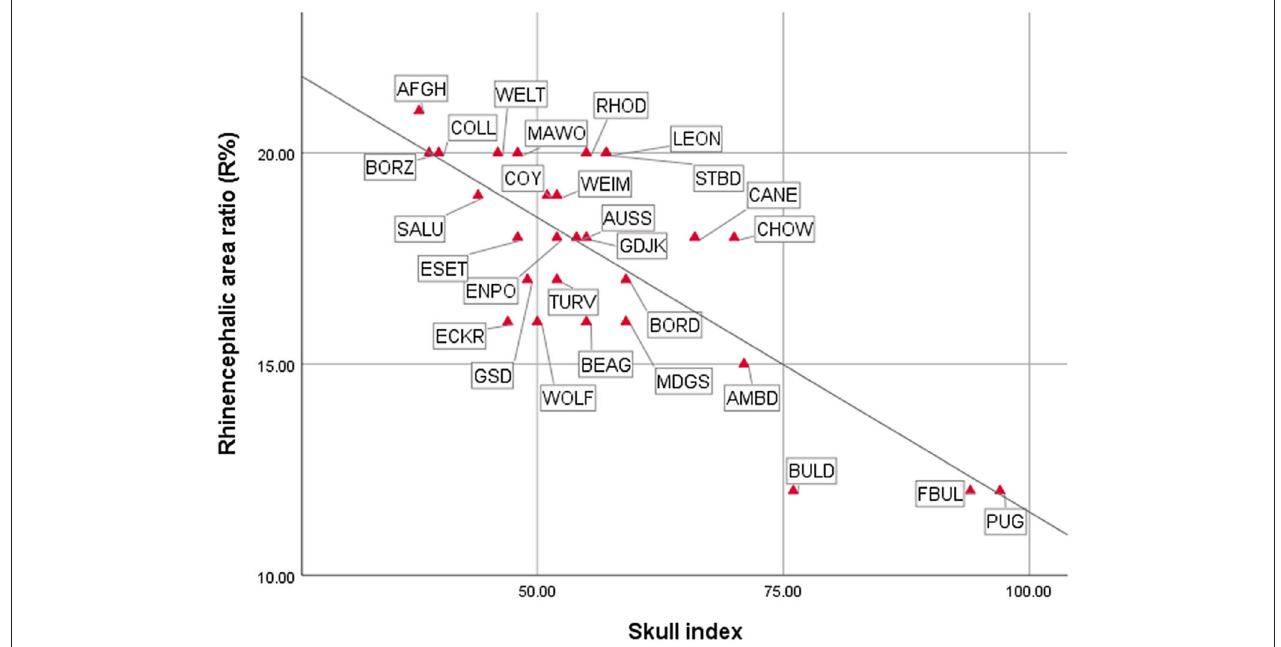
FIGURE 14 | Correlations between cranial and endocranial measurements. For breed/species name abbreviations, see Figure 10 .